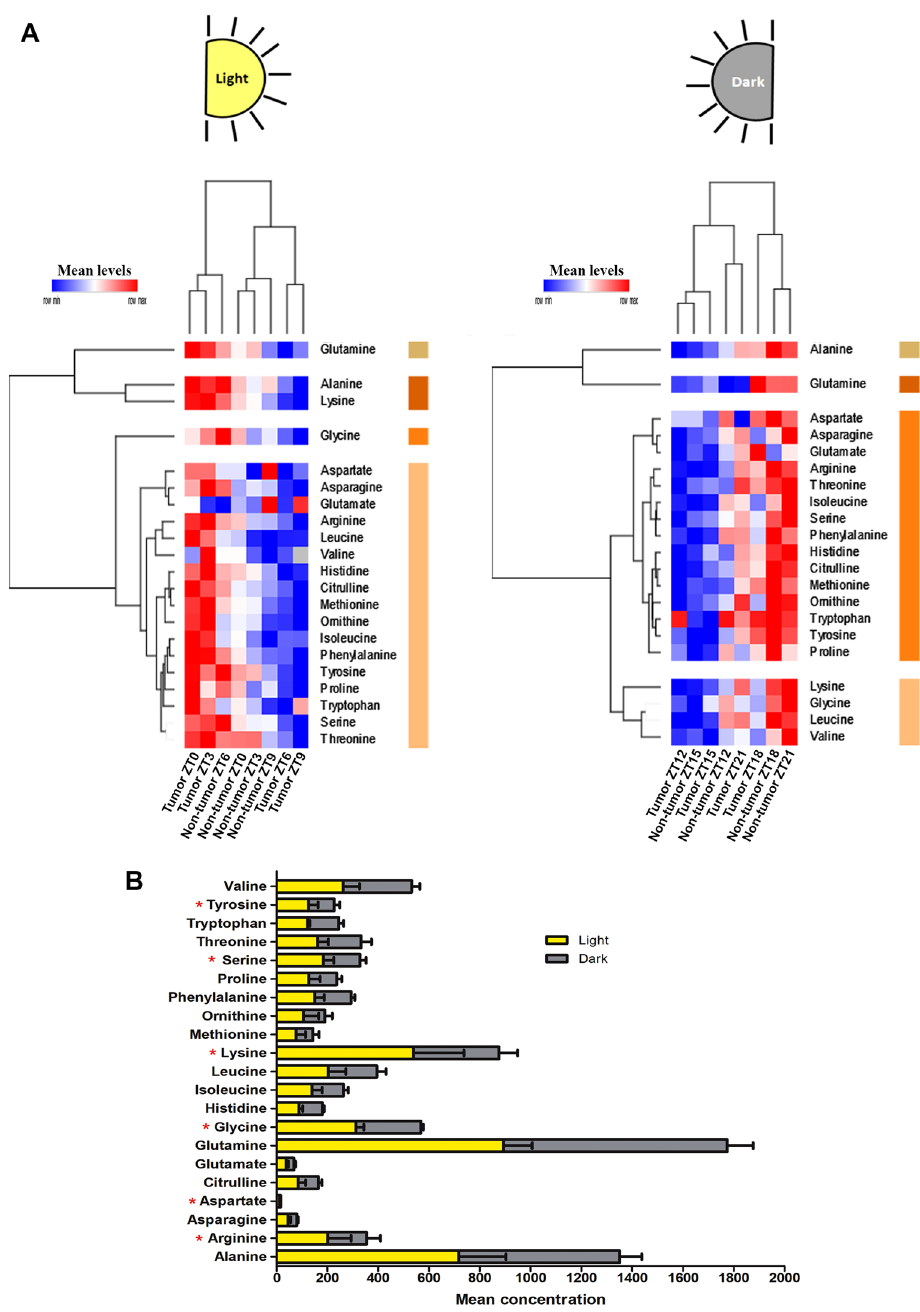
Figure 3. Profile of AAs levels evaluated daily in tumor-bearing and non-tumor bearing mice. ( A ) Heat maps illustrating the normalized mean levels of AAs, visualized as minimum “blue”-maximum “red” values. We used two factors of clusterization (AAs by row and tumor presence by column; Euclidean distance analysis). The right-aligned colors indicate the four main clusters of AAs in the light and dark phases. Light phase included ZT0, ZT3, ZT6 and ZT9 periods. Dark phase included ZT12, ZT15, ZT18 and ZT21 periods . ( B ) Horizontal bar graphic showing the differences in plasma AAs (mean concentration ± S.E.M.) between light (ZT0, 3, 6, and 9) and dark (ZT12, 15, 18, and 21) phases in the presence of tumor. * P <